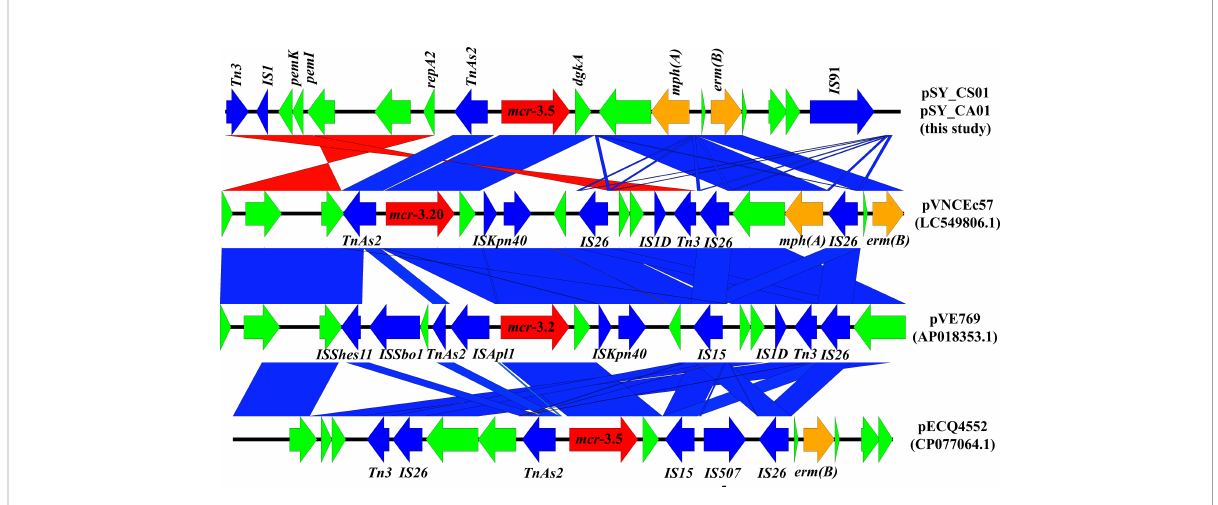
FIGURE 8 Linear comparison of surrounding regions of mcr-3 . The arrows indicate directions of gene transcription. mcr-3 is labeled in red arrow, while other antimicrobial resistance genes are labeled in orange. Mobile genetic elements are indicated in blue and other functional gene are in